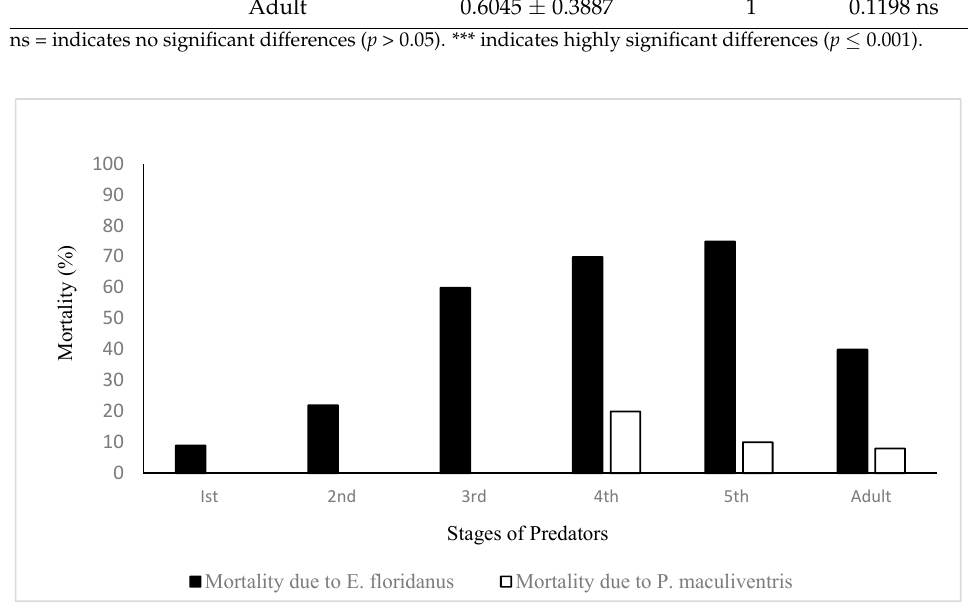
Figure 1. Mortality of two predators’ life stages without fall armyworm offered as prey.